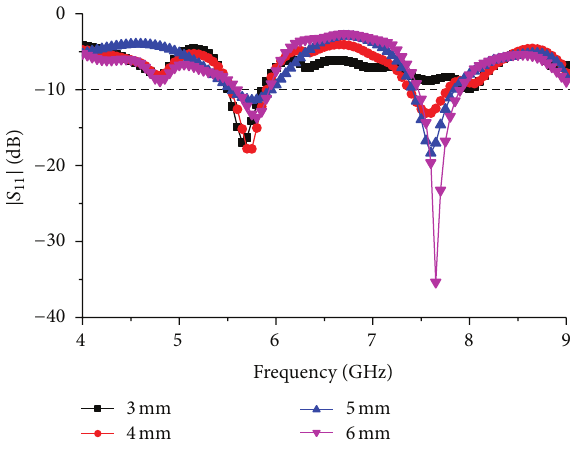
Figure 4: Response to the parametric change in the radius “ 𝑅 .” Figure 5: Response to the parametric change in feed-line width “ 𝑐 .”